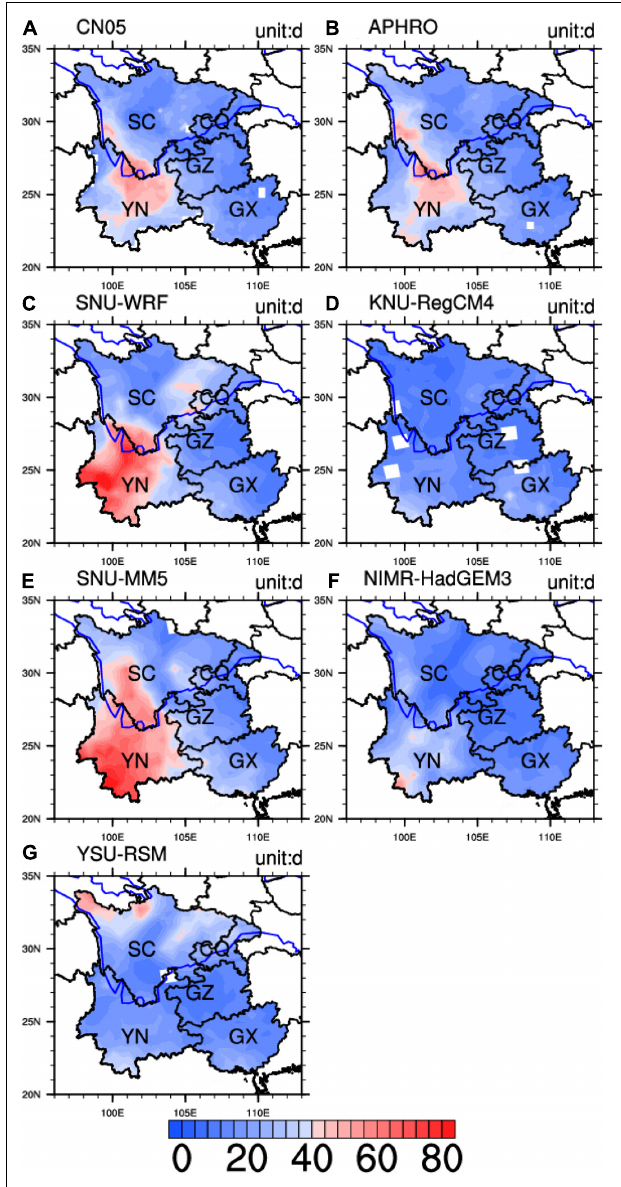
FIGURE 12 | Spatial distributions of the GEV 20-yr return value of the AMDSL. (A) CN05, (B) APHRO; and five RCMs: (C) SNU-WRF, (D) KNU-RegCM4, (E) SNU-MM5, (F) NIMR-HadGEM3, and (G)